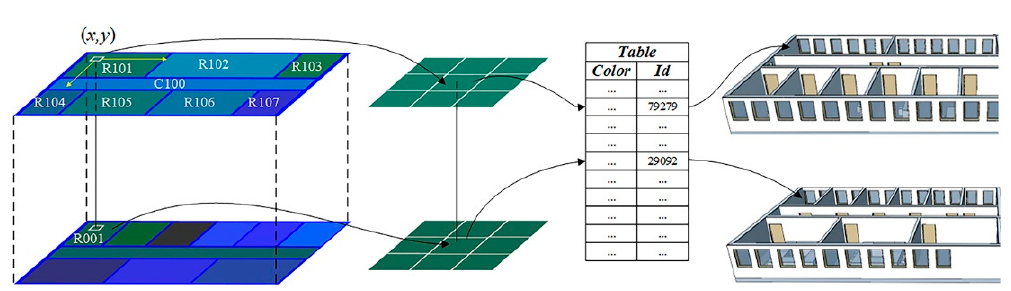
Figure 11. Diagram of vertical search.